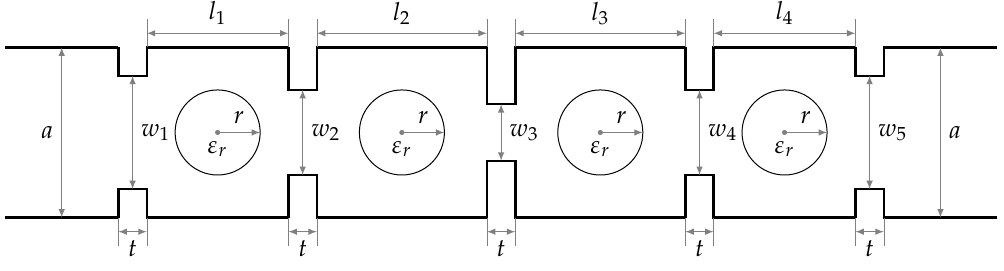
Figure 7. Layout of the dielectric loaded filter in rectangular waveguide: a = 19.05 mm, t = 2 mm, r = 2.31 mm, ε r = 19.5, w 1 = w 5 = 13.014 mm, w 2 = w 4 = 8.141 mm, w 3 = 8.780 mm, l 1 = l 4 = 8.04 mm, and l 2 = l 3 = 12.585